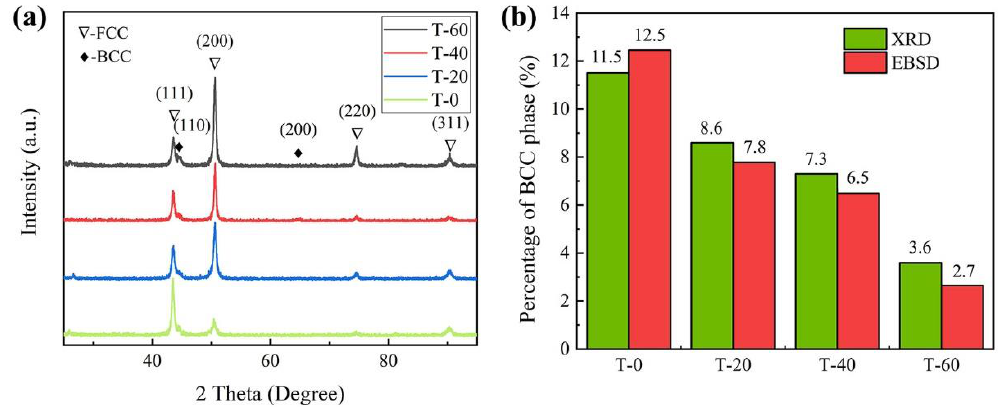
Figure 8. Phase results of LMD-Al 0.5 FeCoCrNi walls under different heat dissipation rates: ( a ) XRD; ( b ) Percentage of BCC phase. ( b ) Percentage of BCC